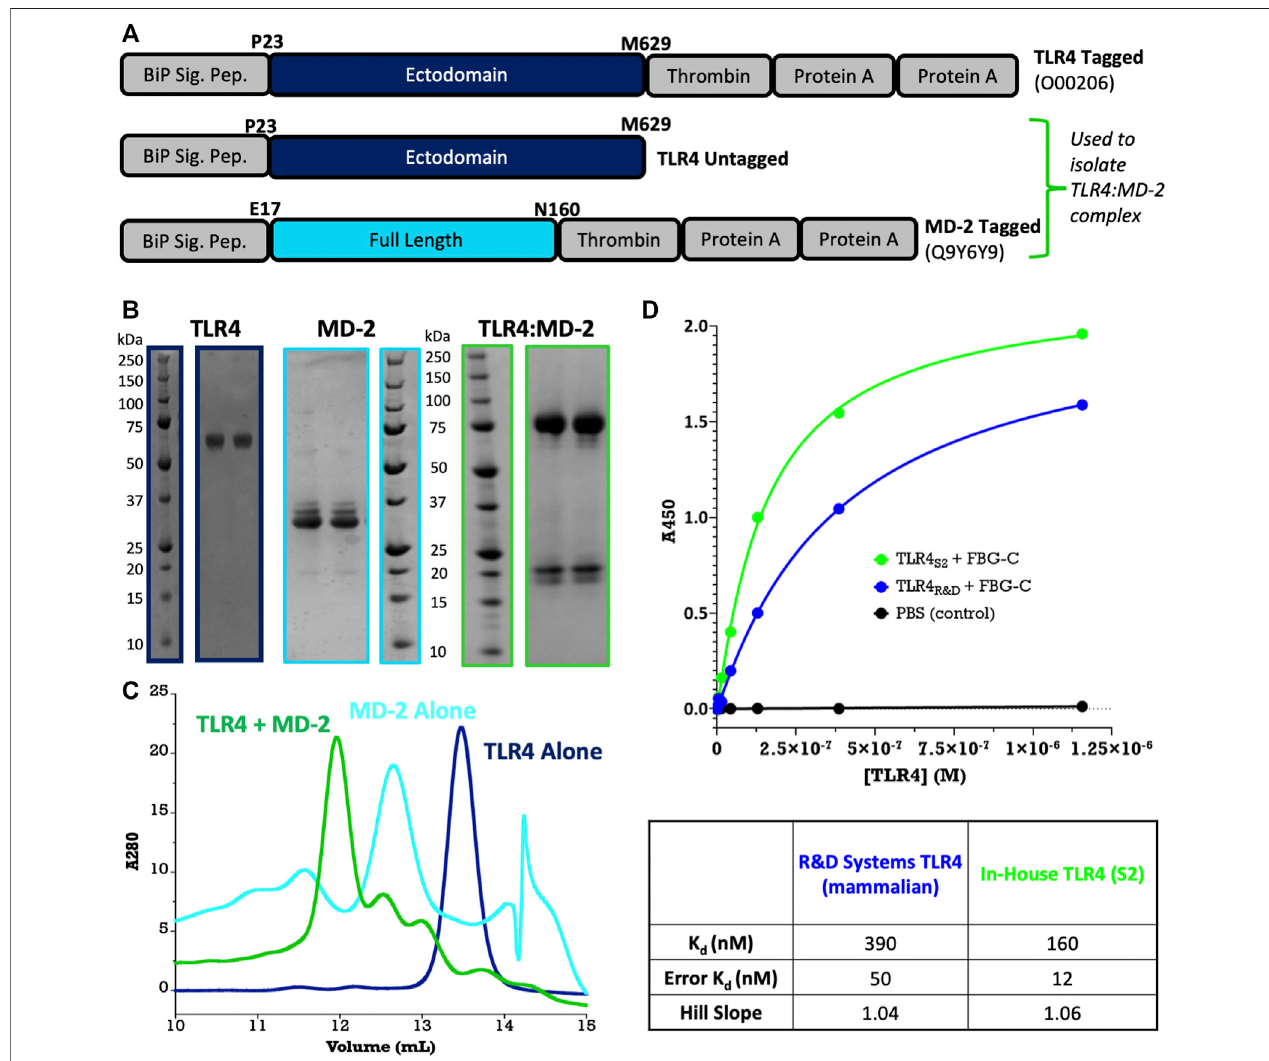
FIGURE4| Large-scalepuri fi cationofTLR4andMD-2. (A) ConstructdesignusingpExpreS 2 -1-CRPAandpExpreS 2 -2. (B) FinalpurityforTLR4,MD-2,andTLR4: MD-2 complex after IgG pull-down and size-exclusion chromatography (SEC). In the TLR4 and TLR4:MD-2 samples, the Protein A tag has been removed, while in the MD-2 sample, the tag is retained for stability. All SDS-PAGE bands were con fi rmed by in-gel tryptic digest MSMS. (C) Analytical SEC binding assay shows that individually puri fi ed TLR4 and MD-2 associate into a complex as expected. It is to be noted that MD-2 exists as a mixed homo-oligomer by itself in solution and, therefore, elutes before the larger TLR4 monomer. (D) Activity assay con fi rms that TLR4:FBG-C binding is similar between S2-derived and commercially available mammalian cell-derived TLR4 from R&D Systems. Data are presented from a single biological replicate and were fi t via nonlinear regression to a one-to-one saturation binding model using GraphPad Prism.